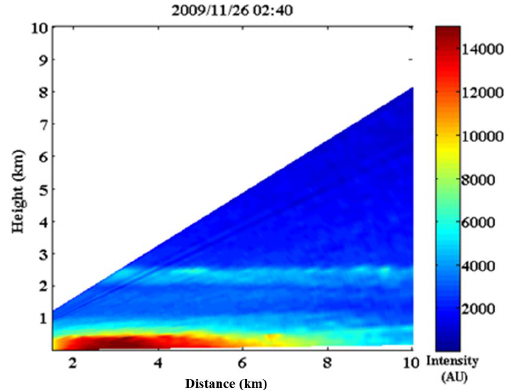
Figure 7. Range height indicator (RHI) plot of the lidar backscat- tered signal at 532nm of the lower troposphere. The lidar measure- ments were taken at NCU, Chung-Li, on 26 November